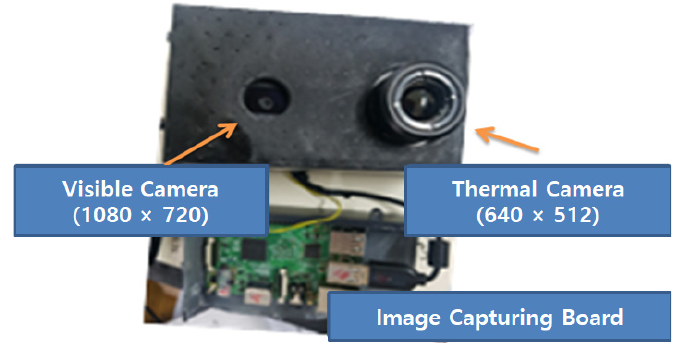
Figure 5. Stereo camera configuration of visible and infrared camera.